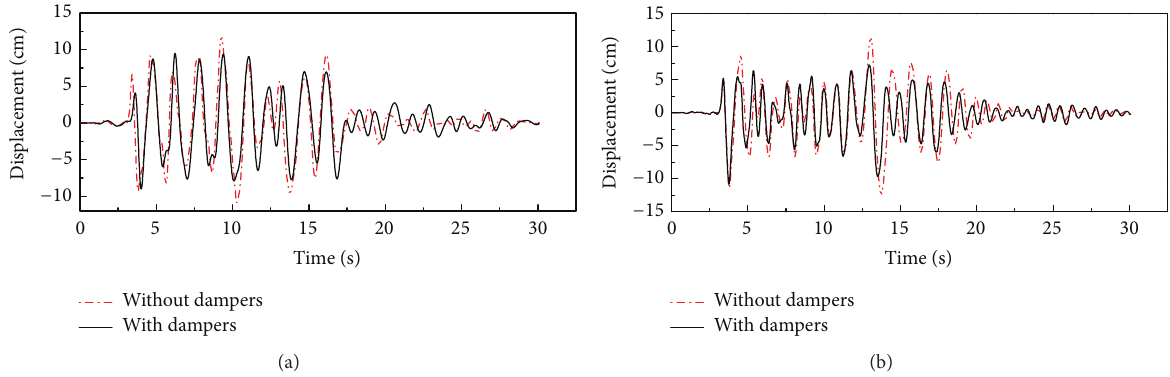
Figure 9: Time histories of the displacement of the bridge deck: (a) longitudinal direction; (b) transverse direction.